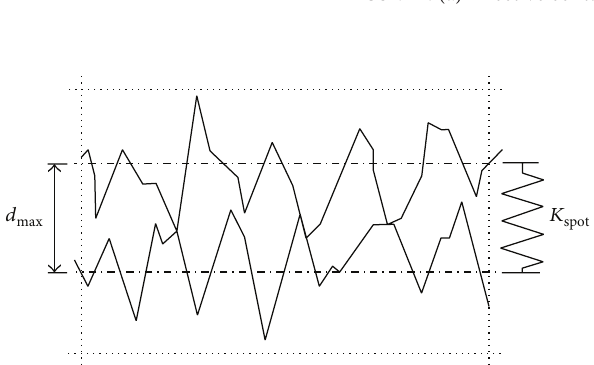
Figure 3: Connection between two contact